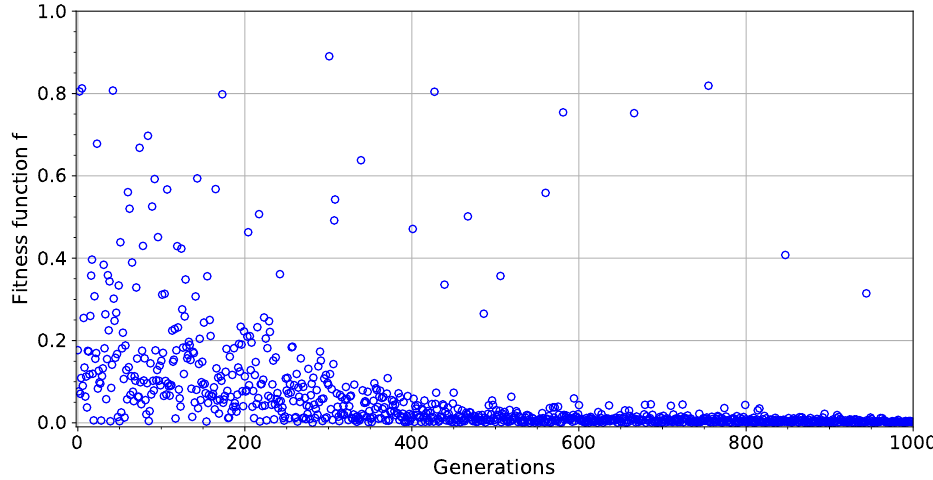
Figure 3. Minimized value of objective function for medium weight